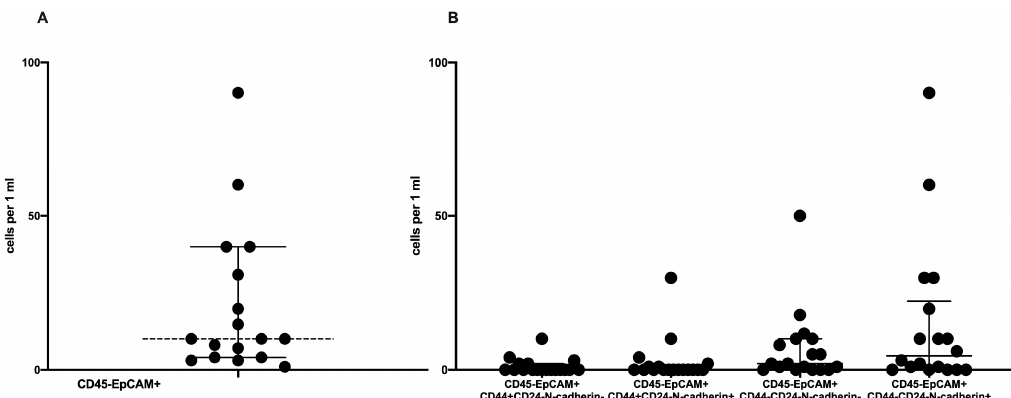
Figure 1. Counts of circulating tumor cells (CTCs) in breast ‐ cancer patients. ( A ) all EpCAM ‐ positive CTCs; ( B ) CTC subsets by stem and epithelial–mesenchymal-transition (EMT) features. CTCs; ( B ) CTC subsets by stem and epithelial–mesenchymal ‐ transition (EMT) features.